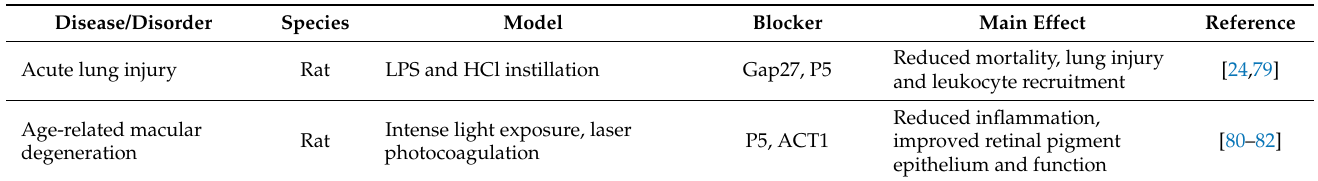
Table 2. Effects of peptide connexin hemichannel blockers on human and animal models of inflam- matory